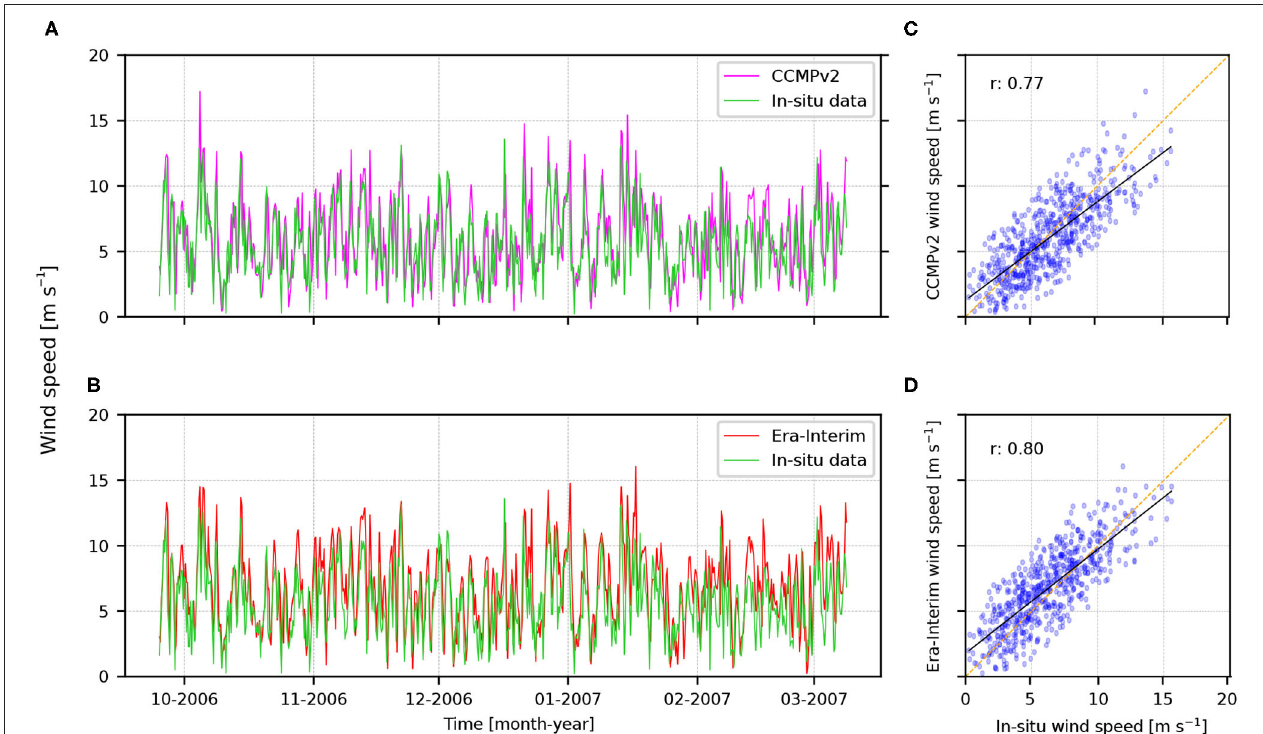
FIGURE 3 | Comparison of wind speed time series from: hourly in-situ data (solid green line) from an oceanographic buoy located at 40.98 ◦ S, 57 ◦ W (Site B, Figure 1B and Table 2 ) and (A) CCMPv2 (solid magenta line) and (B) Era-Interim (solid red line) data extracted at the nearest grid point. The wind speed data from CCMPv2 and Era-Interim used here have a 6-h temporal resolution. (C,D) Scatter plot between the time series shown in (A,B) together with the linear fit by least-squares (solid black line). r is the correlation coefficient and the line y = x is shown in